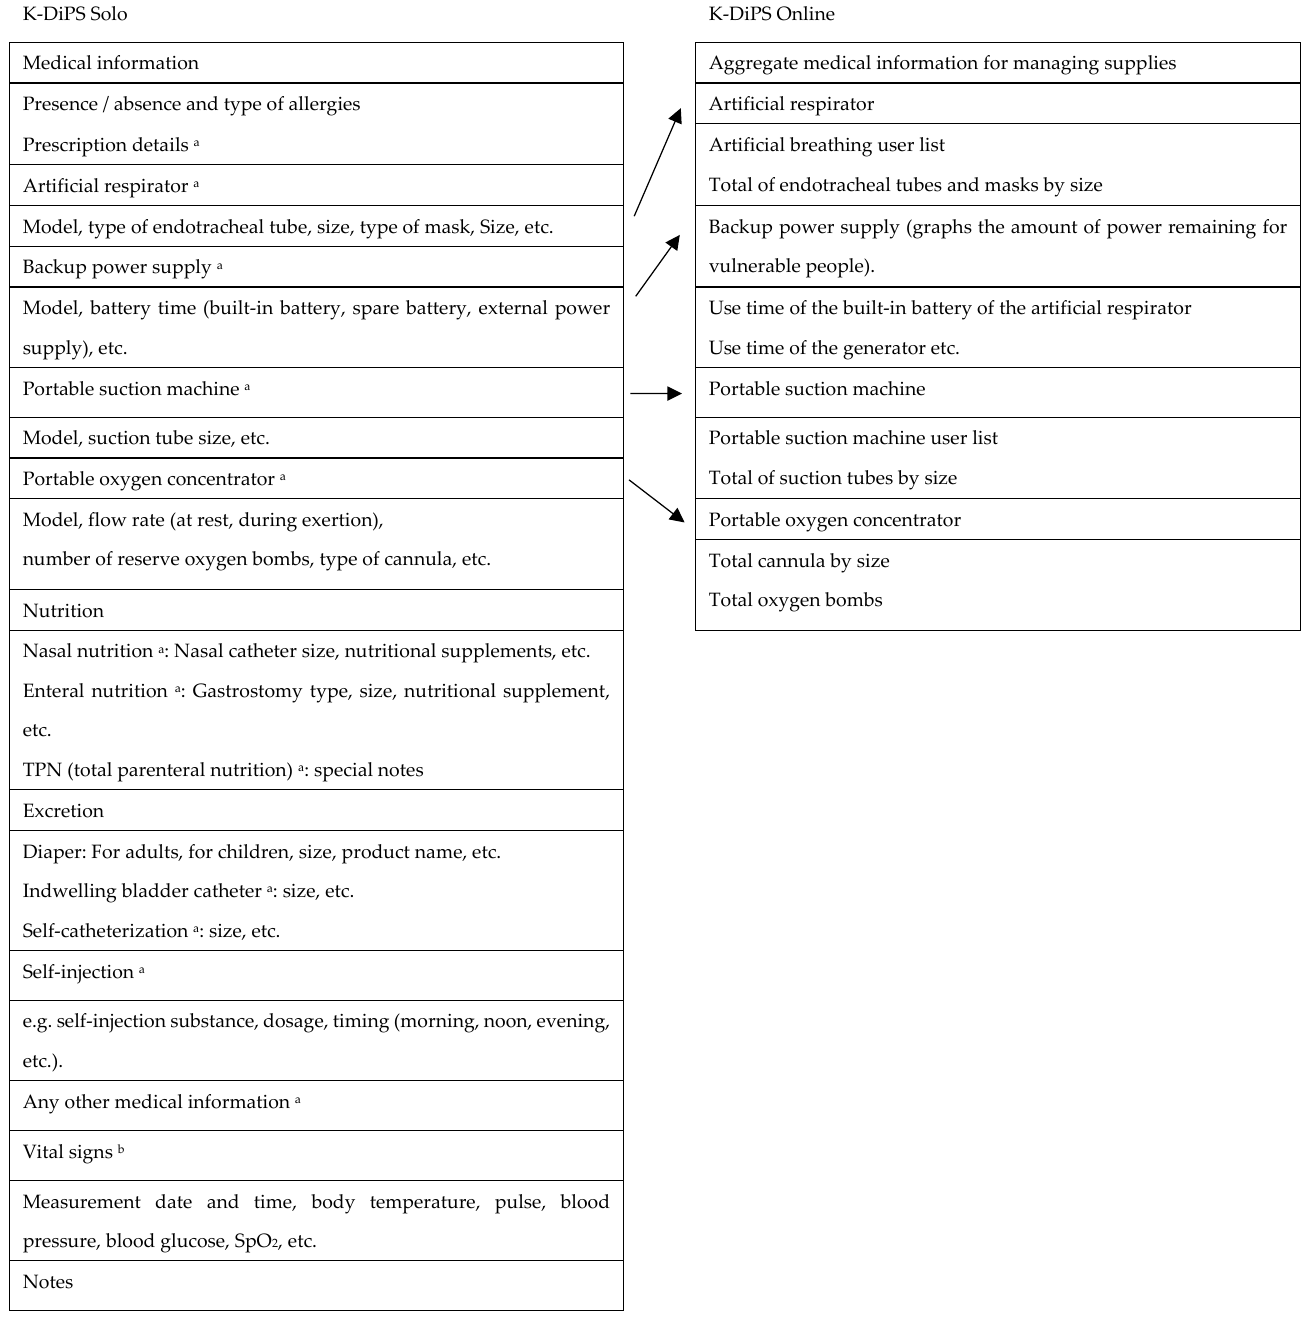
Figure 5. Medical information included in KDS and corresponding data in KDO. a The app contains a function to allow users to take a picture and save information. b The function that can record vital signs was implemented in April 2022 with the version upgrade of KDS, and cannot yet synchronize with